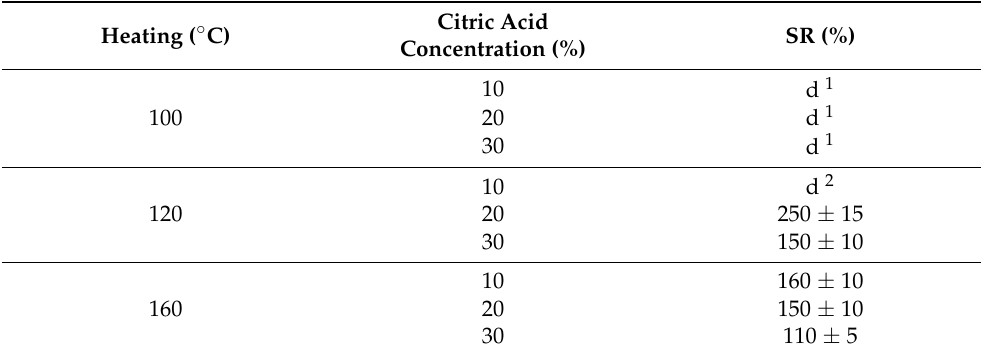
Table 2. Swelling rate of CNC films plasticized with 15% glycerol and determined after immersion in water for 24 h. The effect of heating at 100, 120, and 160 ◦ C for 10 min, and citric acid addition at 10, 20, and 30%